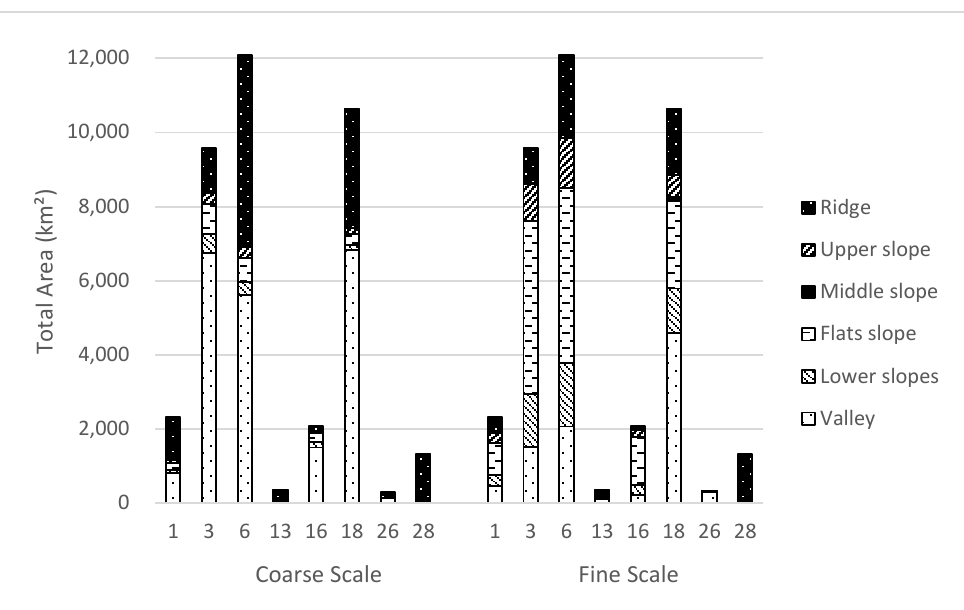
Figure 10. The proportion of SPC of the total area for each class, for both coarse and fine scales of slope analysis.